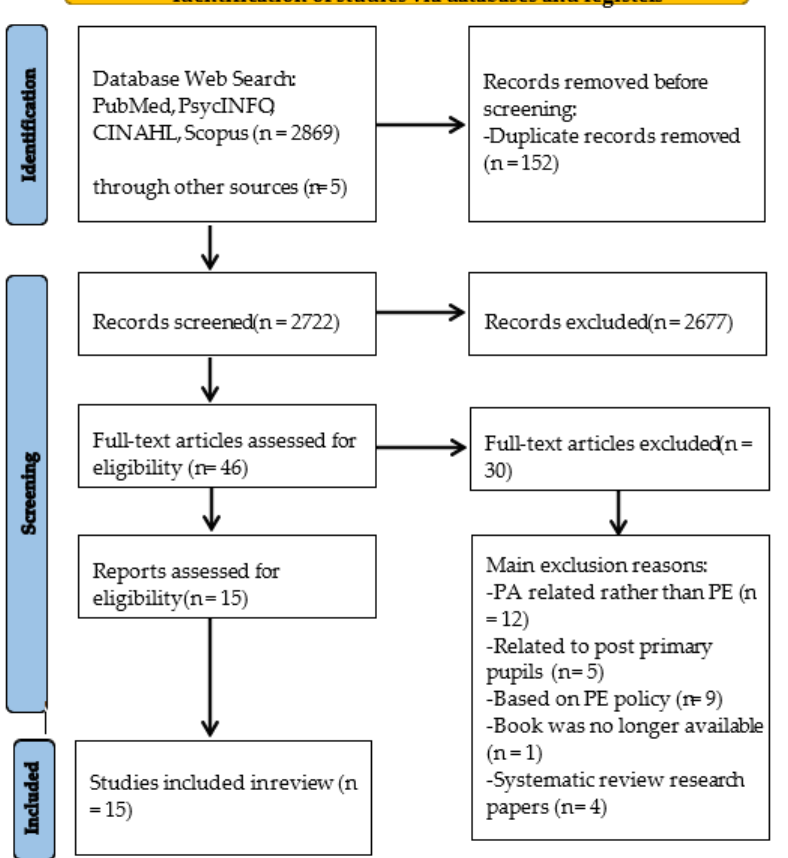
Figure 1. PRISMA-ScR flow diagram for study selection.